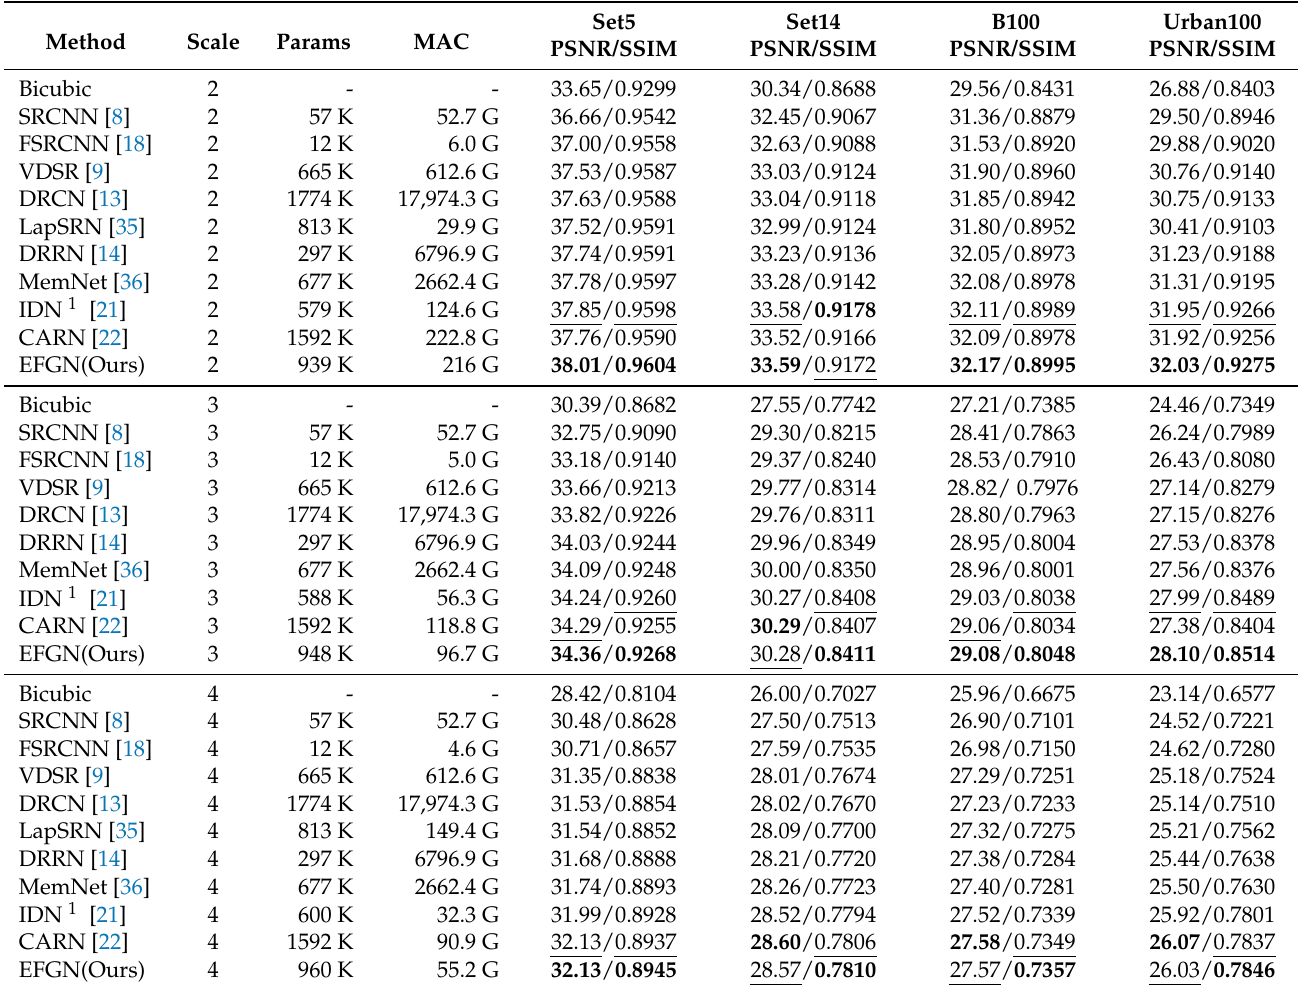
Table 4. Quantitative results for scale factor × 2, × 3 and × 4 on benchmarks. Best and second best results are bold and